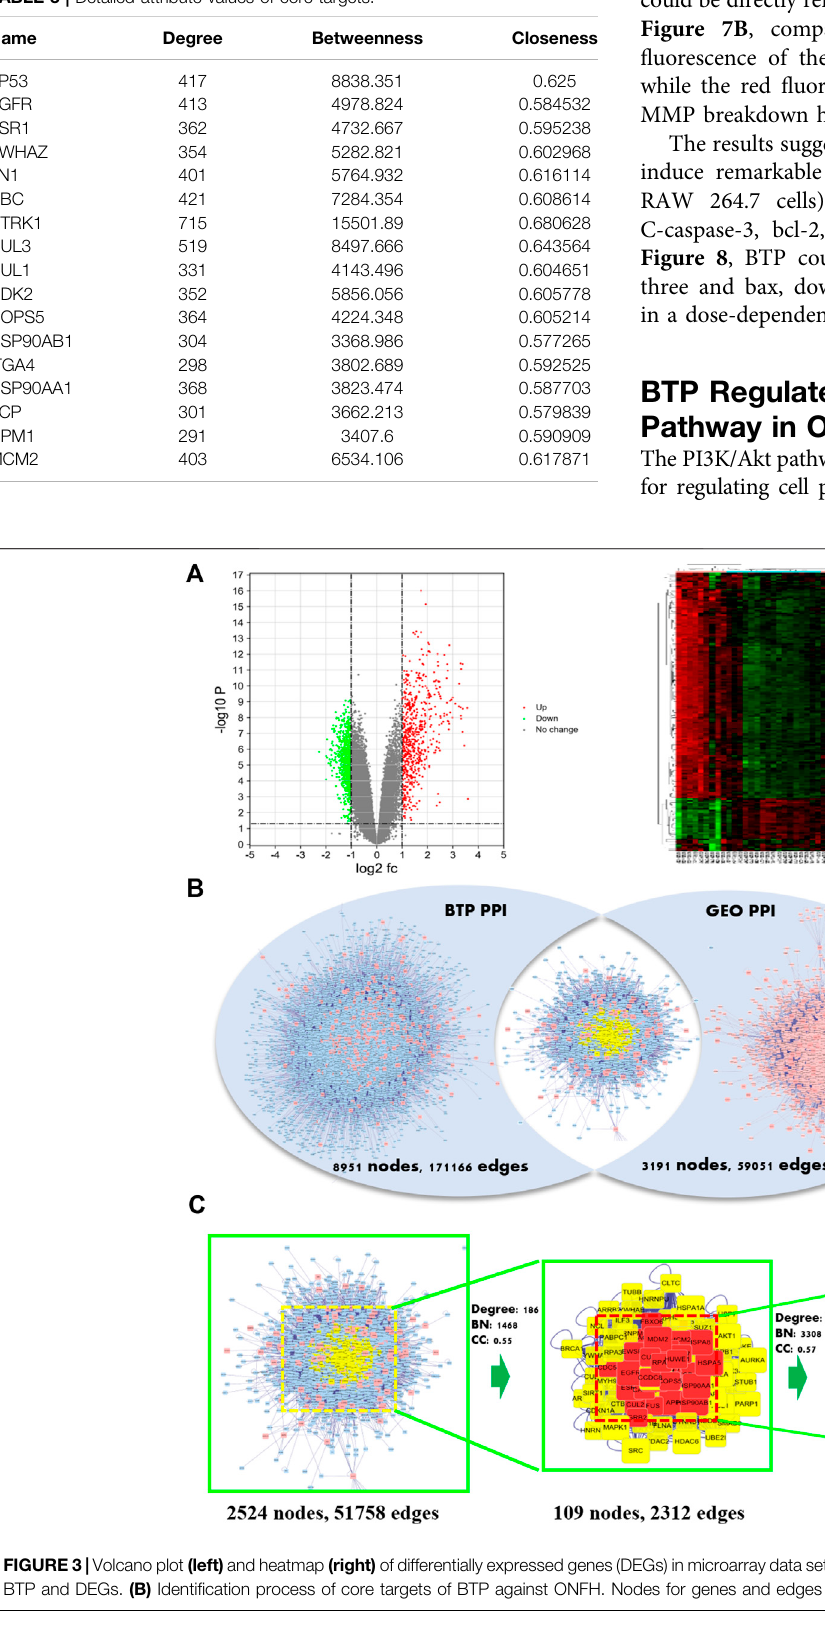
Frontiers in Pharmacology |